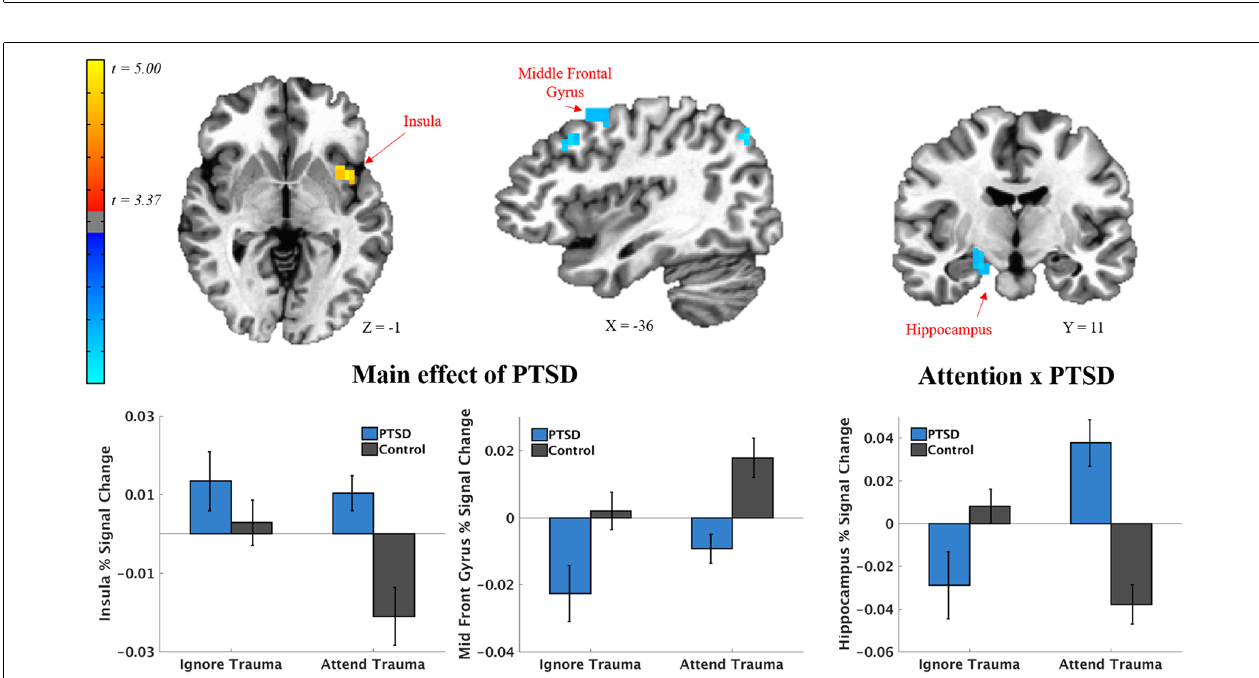
FIGURE 7 | Significant clusters from group-level LME models of adaptive neurofeedback encoding where there was a main effect of PTSD (left) or interaction (right) with PTSD and attention instruction (attend-to-word vs. ignore word). Adaptive neurofeedback encoding refers to brain region activity that scales linearly with the feedback signal itself. In this paradigm, the feedback signal was the alpha channel (i.e., opacity) of the target stimulus. The feedback signal updated on a trial-by-trial basis depending on the participant’s hyperplane, which itself was determined through the fit of the participant’s brain state on a given trial with the SVM classifier. Higher alpha channels of the target stimulus indicate positive feedback, such that they inherently make the task easier and therefore reinforce brain states that preceded them. Below each significant cluster is a bar graph indicating mean activation differences per task condition as a function of PTSD.